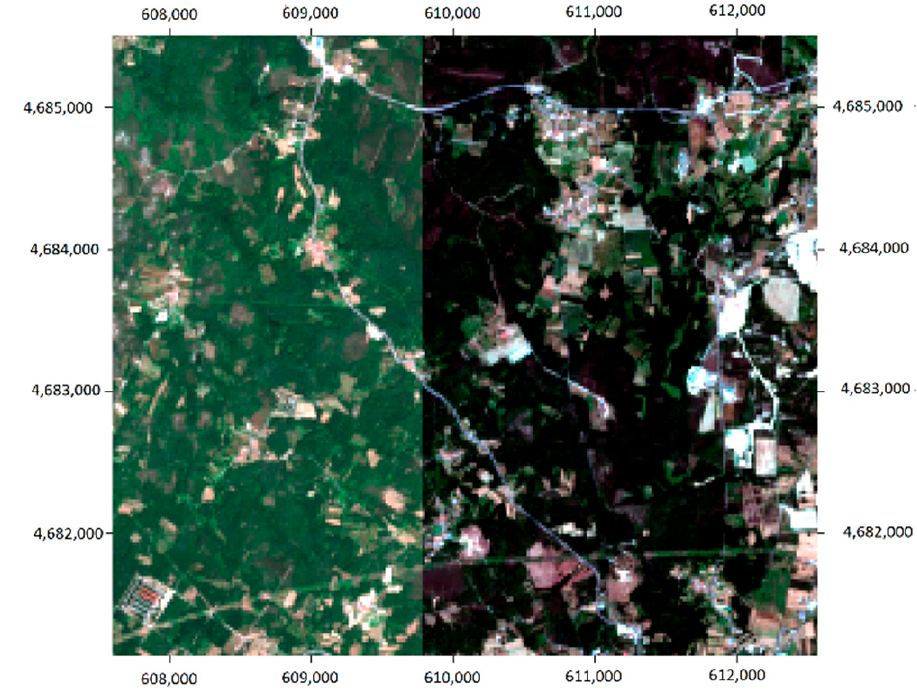
Figure 3. RGB color composition of TNG and TPG in the overlapping area (TPG is superimposed to TNG). Tile acquisition date: 19/07/2019. Tile acquisition hour: 11:21:19. Acquisition satellite: Senti- nel-2B.